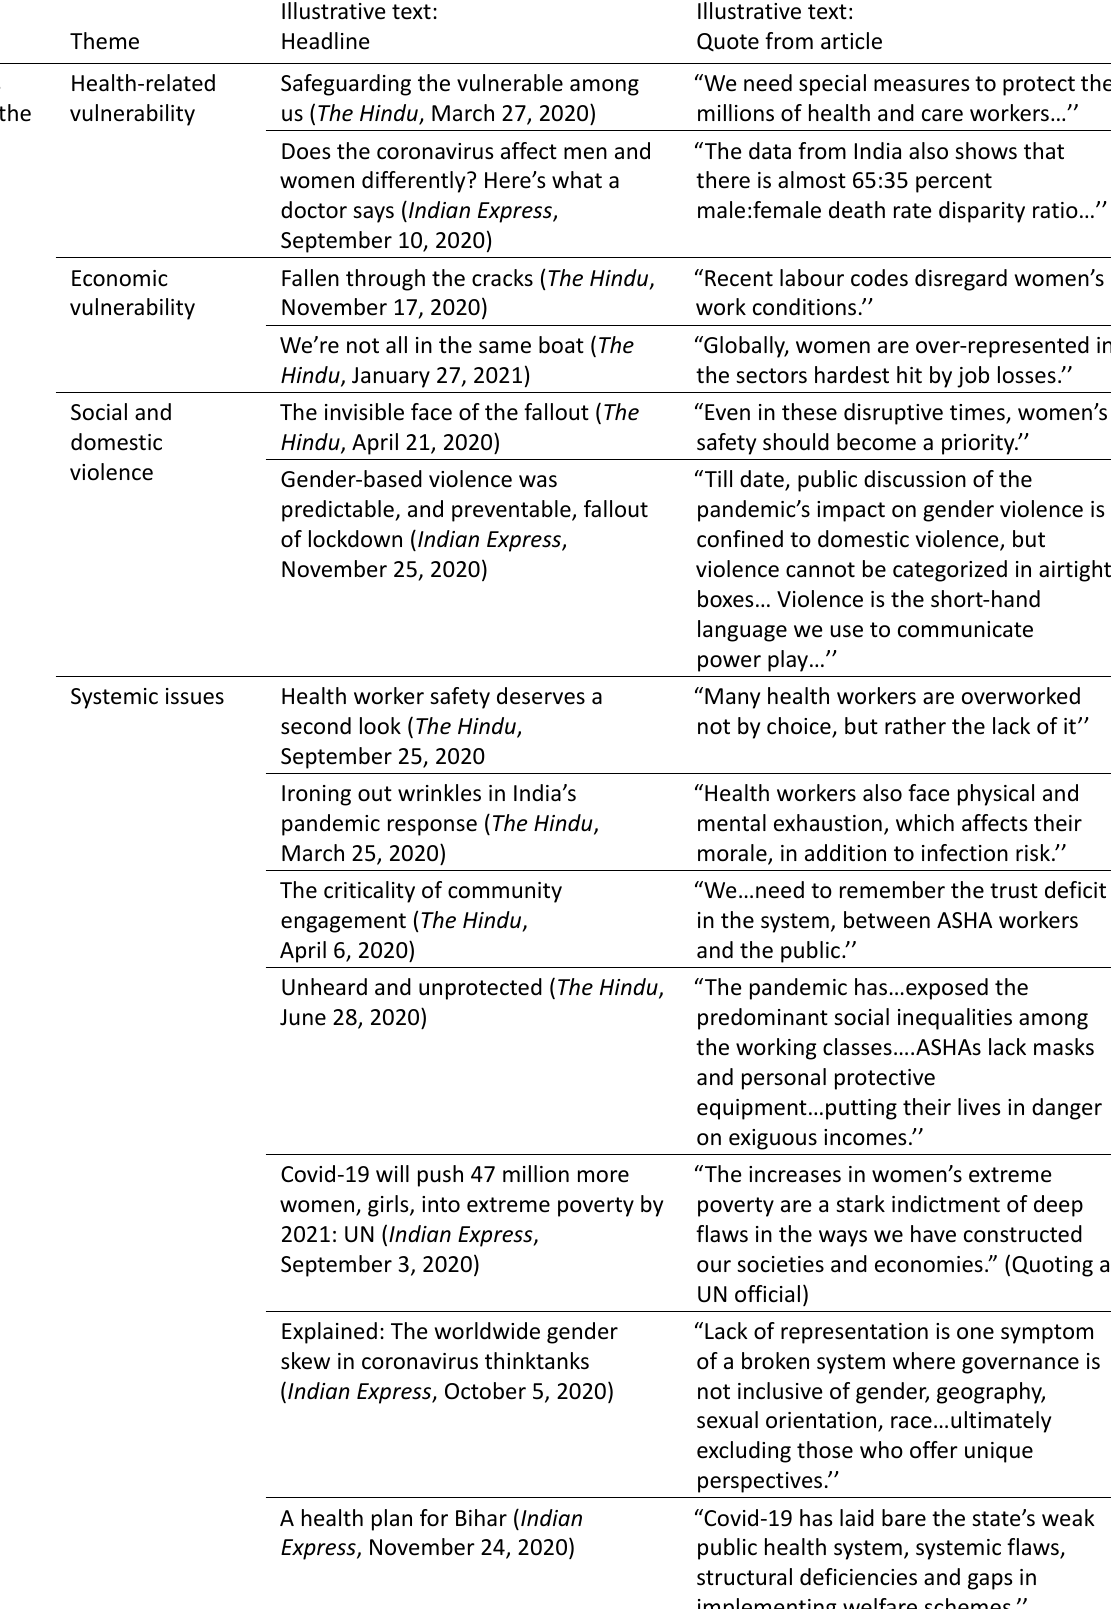
Table 1. Main narrative threads and illustrative extracts from articles